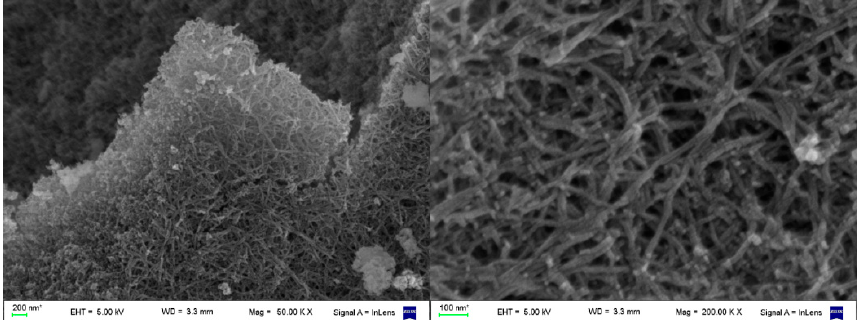
Figure 9. SEM images of the nanotubular entangled network of silica obtained by in situ polymerization of TEOS using as template a gel of 5 in methanol, free of added catalyst.